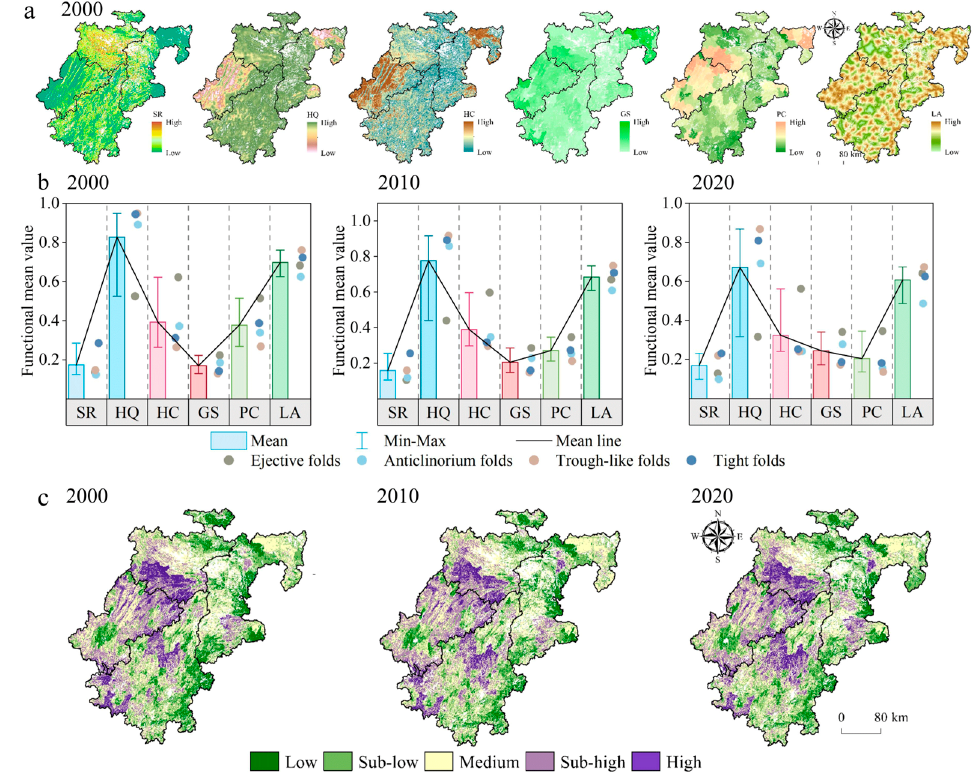
Figure 4. Temporal evolution and spatial distribution of single functions and multifunctionality: ( a ) spatial and temporal distribution characteristics; ( b ) functional mean values; ( c ) cropland multifunctionality; SR: soil retention; HQ: habitat quality; HC: habitat connection; GS: grain supply; PC: population-carrying capacity; LA: landscape aesthetics.